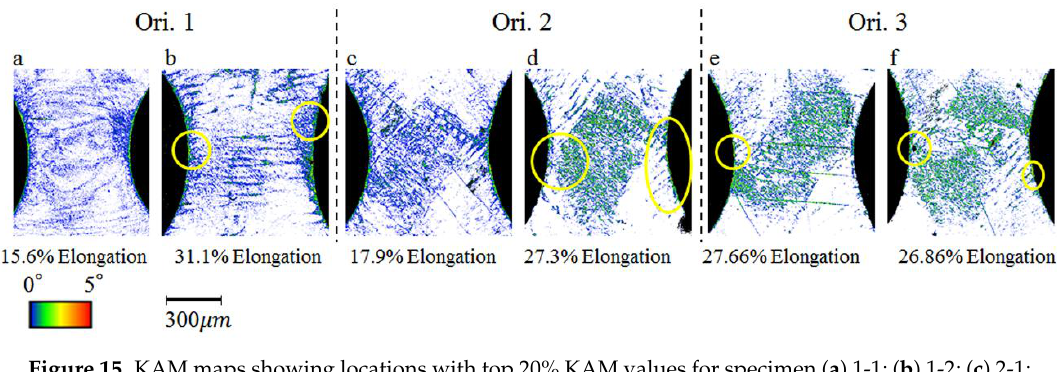
Figure 15. KAM maps showing locations with top 20% KAM values for specimen ( a ) 1-1; ( b ) 1-2; ( c ) 2-1; ( d ) 2-2; ( e ) 3-1; and ( f ) 3-2 before annealing. Yellow circles pointed out nucleation sites same as those in the previous figure. Dashed lines were used to separate specimens with different initial orientations.